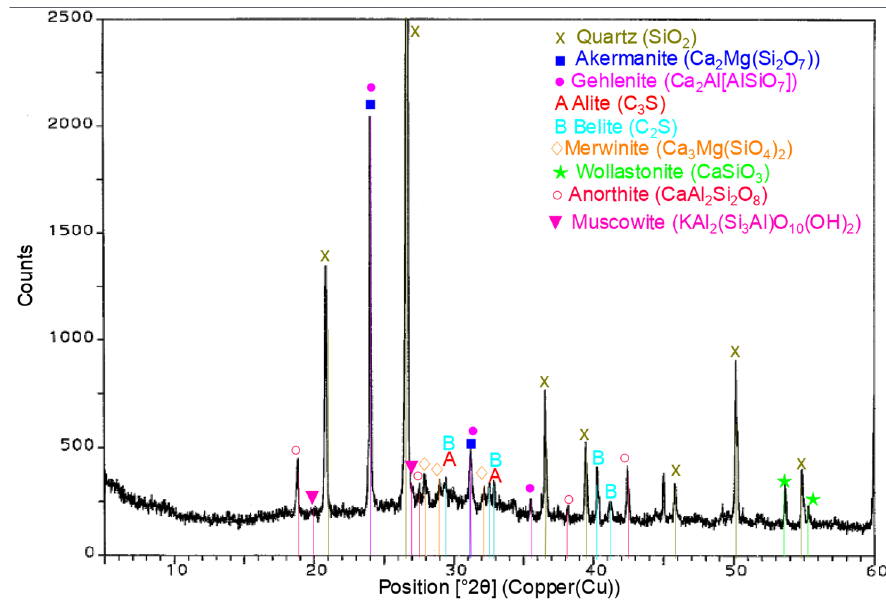
Figure 13. XRD RPC +30% EP after 28 days of curing.